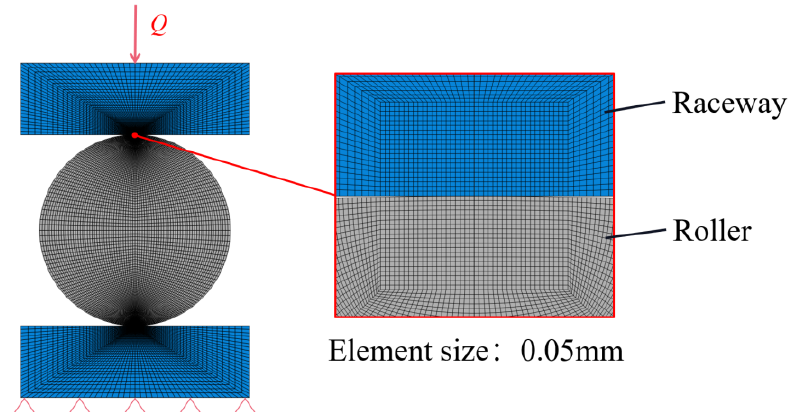
Figure 3. Finite element model of contact between roller and raceway. Table 1. Material properties of bearing